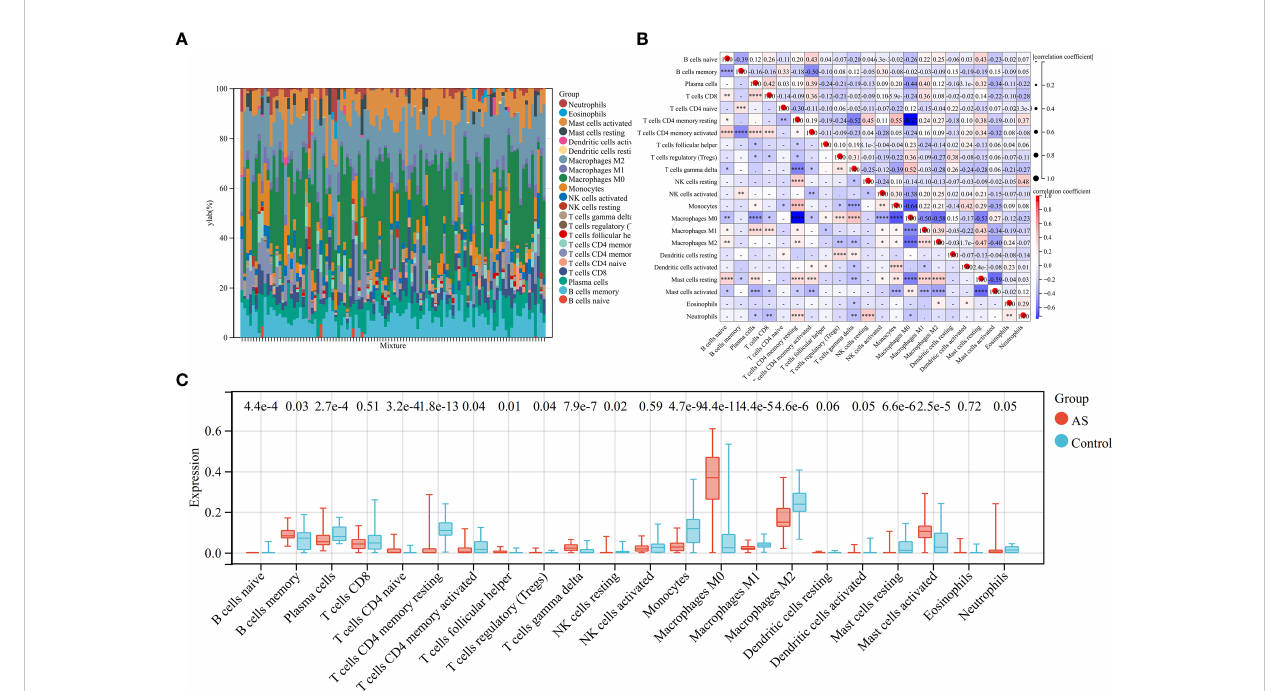
FIGURE 8 Immune in fi ltration analysis between AS and control. (A) The proportion of 22 immunocytes in all samples visualized from the bar plot. (B) Comparison of the proportion of 22 kinds of immunocytes between AS and control groups shown in the vioplot. (C) Association of 22 immunocyte-type compositions. * p < 0.05; ** p < 0.01; *** p <